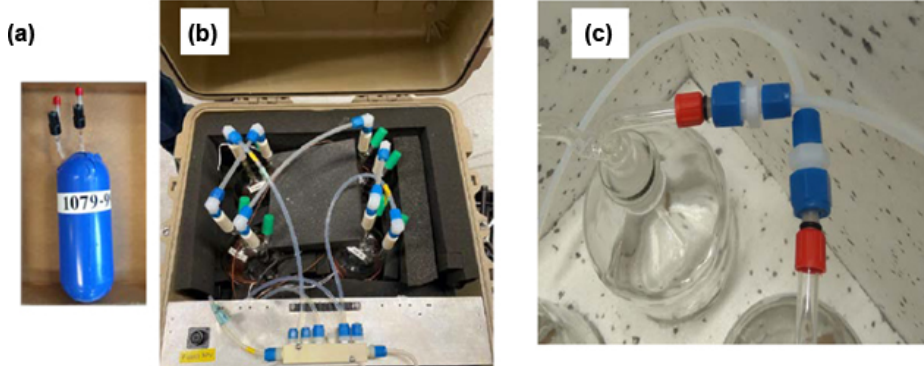
Figure 4. (a) Photograph of one of the glass flasks that were used for the University of Colorado flow reactor. (b) The ozone reactor with four of the flasks plumbed in series contained in an insulated and temperature-controlled field-deployable enclosure. Four flasks were plumbed in series for a total flow reactor volume of 10L. (c) The 2L bottles (borosilicate glass 3.3) used in the flow reactor system from